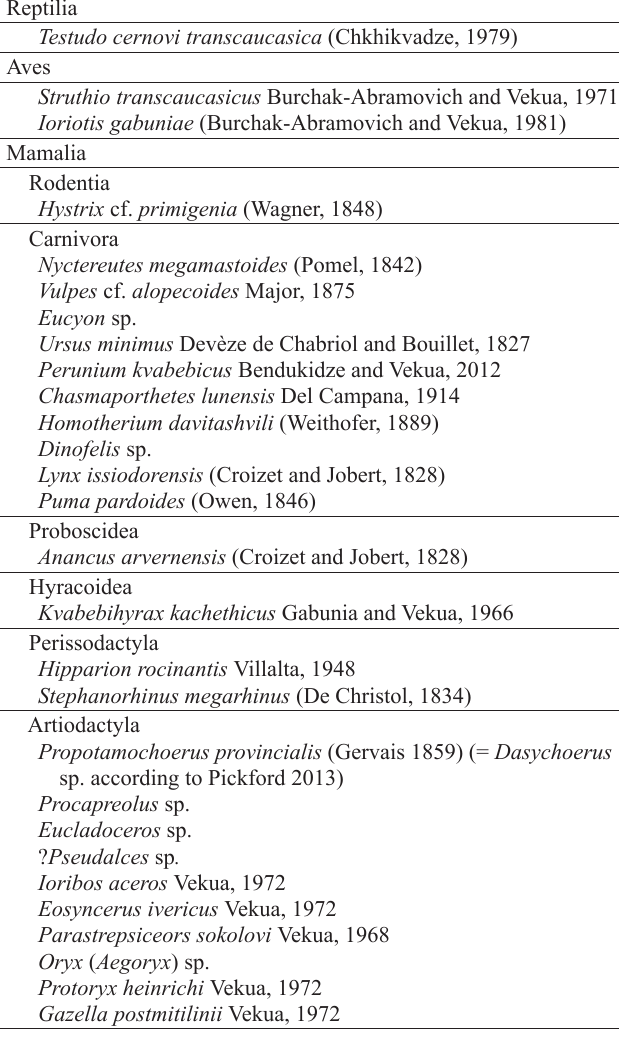
Table 7. List of Kvabebi fauna. The list is based on Vekua 1972; Bur- chak- Abramovich and Vekua 1981; Sotnikova 1989; Hemmer et al. 2004; Agustí et al. 2009; Pickford 2013; Bendukidze and Vekua 2012; Rook et al.